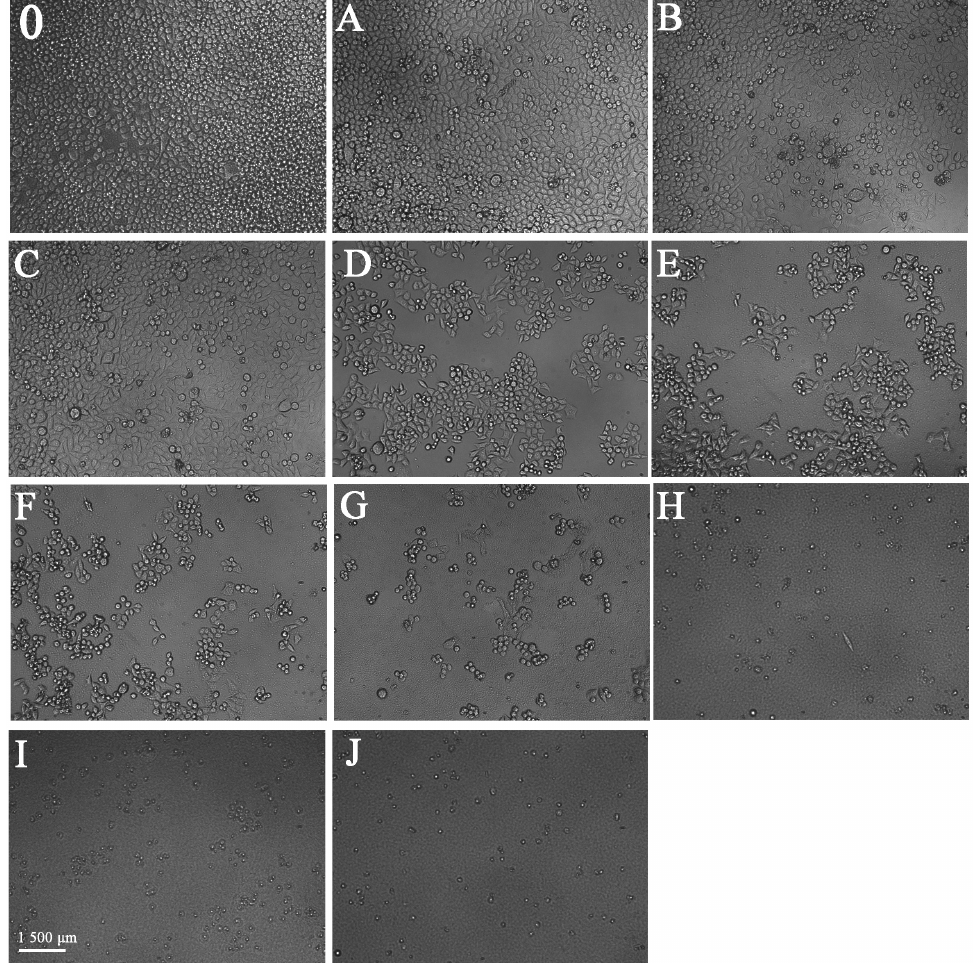
Figure 6. The cell morphological changes of BGC-803 cells after 48 h of anthocyanins treatment was observed by an inverted microscope. ( A – J ) represent anthocyanin concentrations of 3.906, 7.813, 15.63, 31.25, 62.5, 125, 250, 500, 1000 and 2000 µ g/mL, respectively; ( 0 ) represents the blank